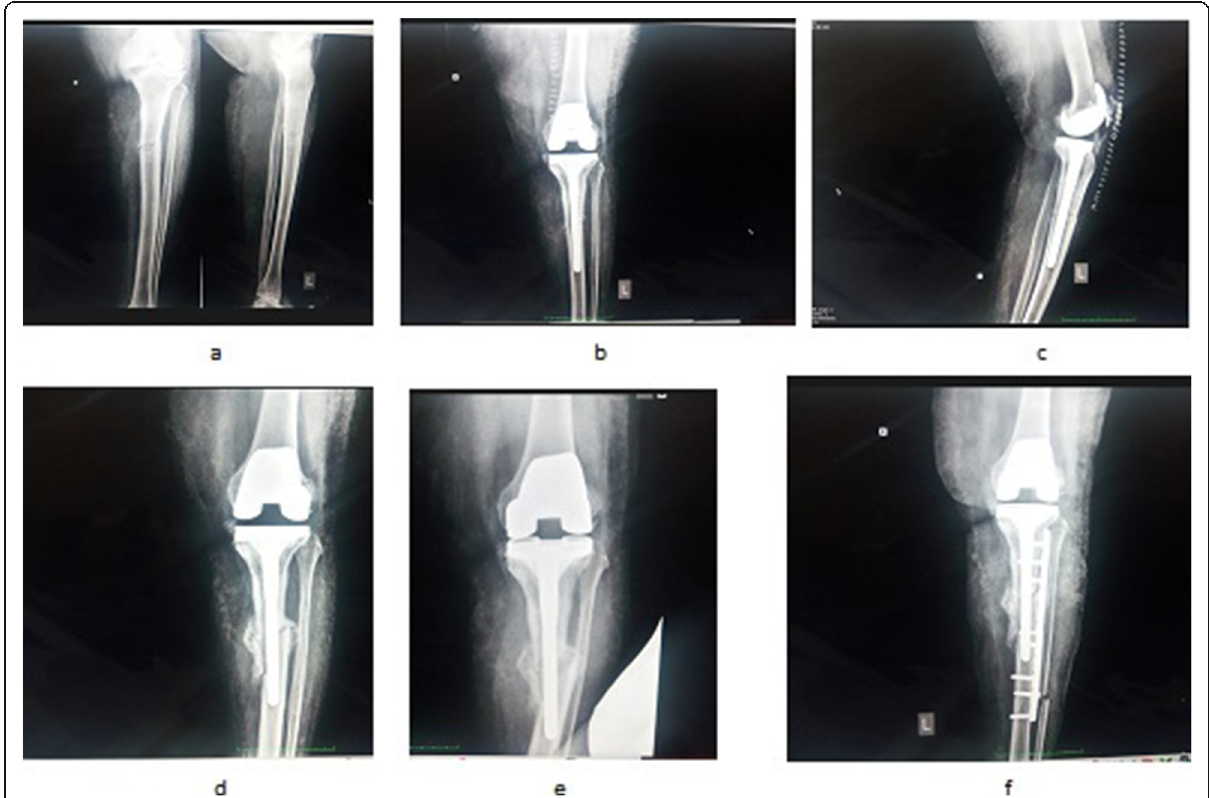
Fig. 6 Left Knee X-rays (complication and intervention) a ) Preoperative anteroposterior and lateral view showing features suggestive of osteoarthritis, with deformity with stress fracture proximal tibia; b ) and c ) Postoperative X-rays anteroposterior and lateral view showing correction of deformity with modular stemmed knee prosthesis with intact fibula; d ) and e ) Follow-up anteroposterior view showing nonunion; f) Recent follow-up anteroposterior view showing healed stress fracture with correction of deformity with modular stemmed knee prosthesis with implant (plate) in situ with resected